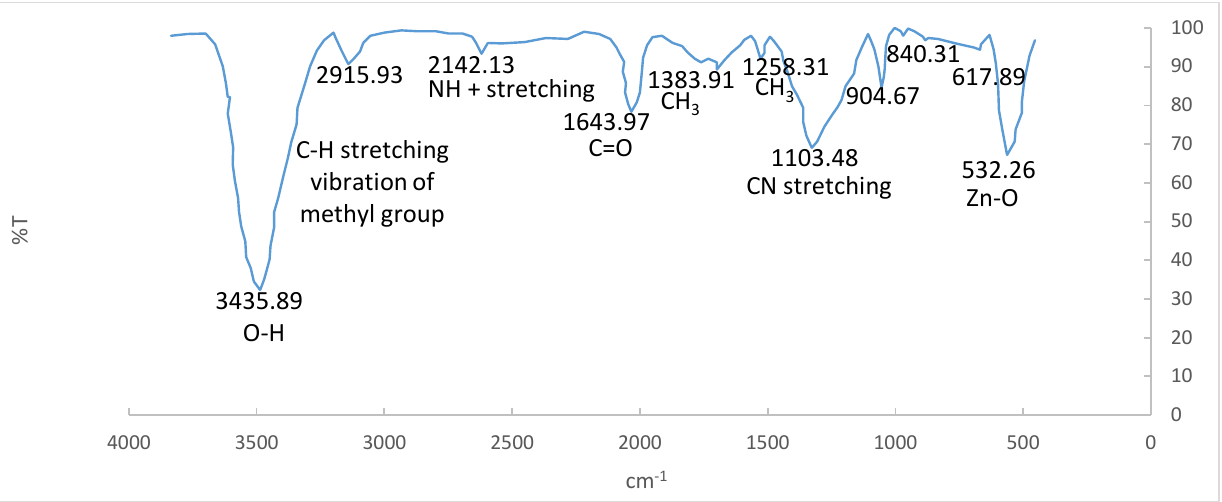
Figure 6. FTIR spectra of the ZnO-Nd